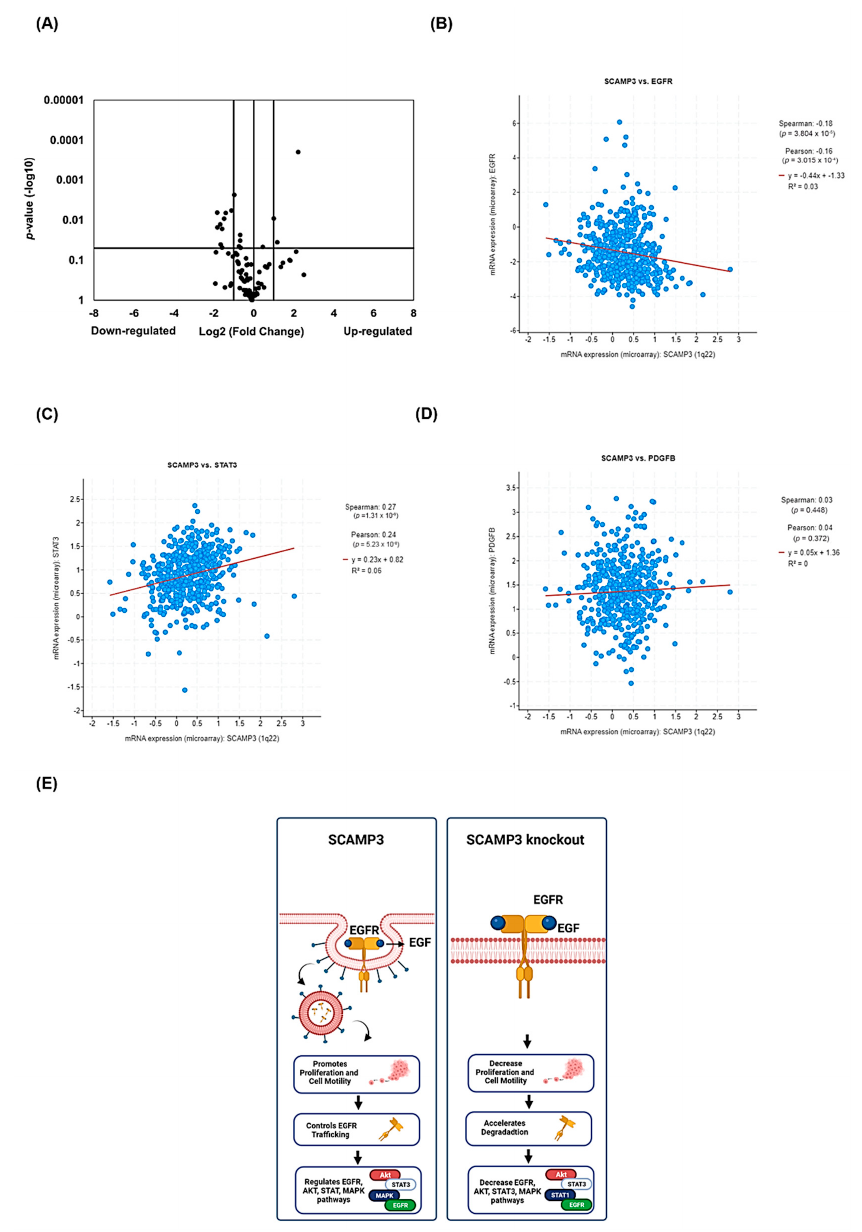
(Supplementary Table S1). The protein encoded by this gene is a member of the STAT family of transcription factors recently identified as a resistance inducer to doxorubicin [37].